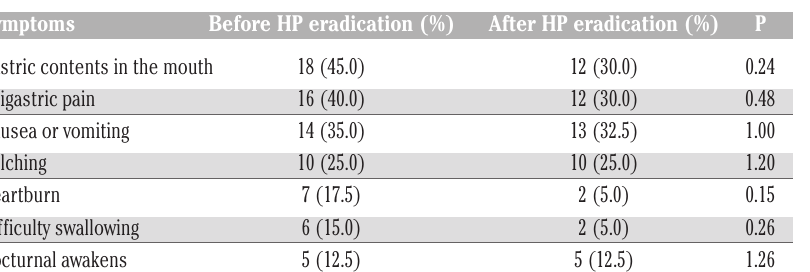
Table 5. Clinical symptoms before and 6 months after Helicobacter Pylori eradication